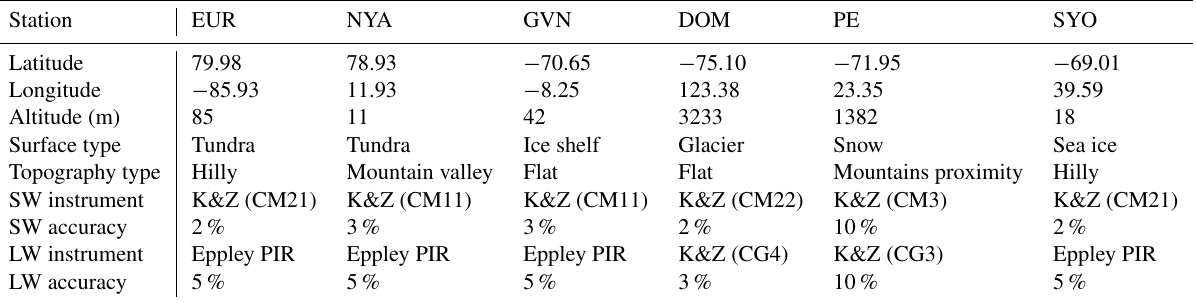
Table 1. Description of the location and instrument specifications of the six AWSs: Eureka (EUR), Ny-Ålesund (NYA), Georg von Neumayer (GVN), Concordia Station Dome C (DOM), Princess Elisabeth (PE), and Syowa (SYO). Measurement accuracies are as reported by the manufacturer on daily totals. PIR denotes the Precision Infrared